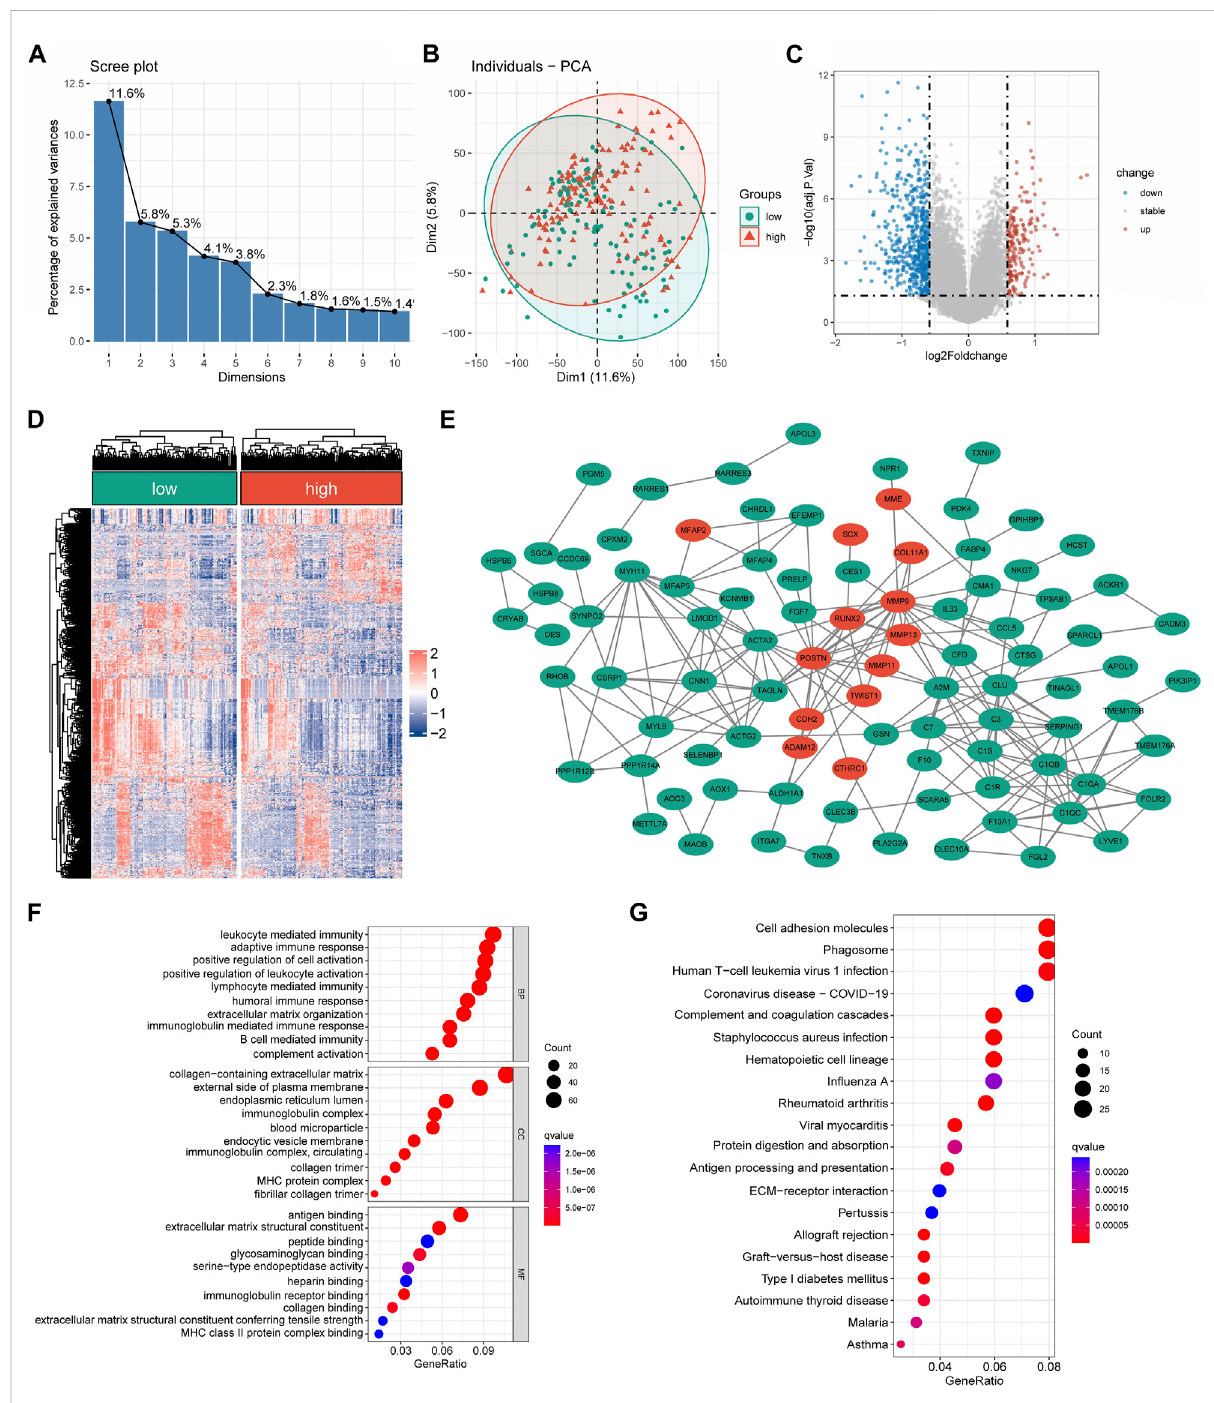
FIGURE 6 The differentiallyexpressedand functionalenrichmentanalysisbetweenhigh-and low-CRLncSiggroups. (A) The screen plot ofPCAanalysisis based on the differentially expressed gene between the low- and high-CRLncSig group. (B) PCA between high- and low-CRLncSig groups on all genes. (C,D) ThevolcanoplotandheatmapofDEGsbetweenthedistinctriskgroup. (E) PPInetworkanalysisofdifferentialexpressedgene. (F,G) The GO analysis and KEGG enrichment pathway